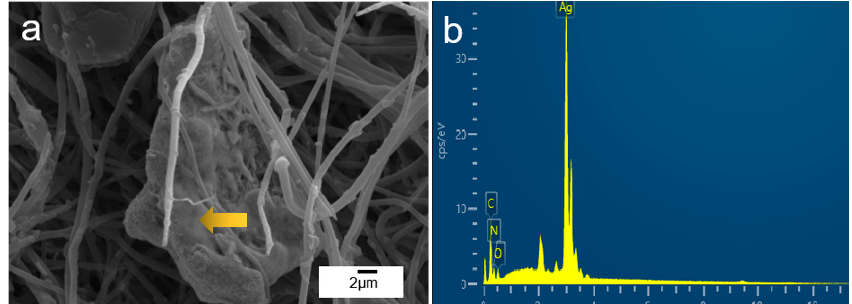
Figure 9. Morphology ( a ) and point scan EDS spectrum ( b ) of E. coli . cultivated on the SF/GEL/KA- N/AgNWs film.